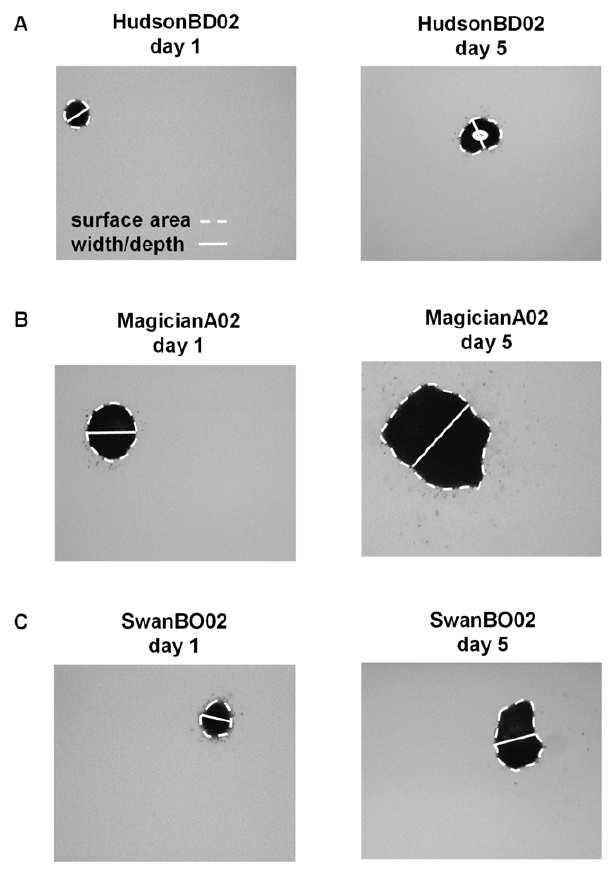
Figure 1. Microcystisaeruginosa colony size measurements. The surface area and width of individual colonies was measured using microscopy and digital image analysis. Example measurements for individual colonies of three M. aeruginosa genotypes ((A) HudsonBD02, (B) MagicianA02, and (C) SwanBO02) measured on days 1 and 5. Stippled white line was traced with a mouse for estimation of surface area. Solid white line represents our approximation of colony depth (see text for explanation). For HudsonBD02 (A), the perimeter of the void in the center of the colony was also traced and its estimated surface area was subtracted from the total surface area. All photos taken at 63 6 magnification.